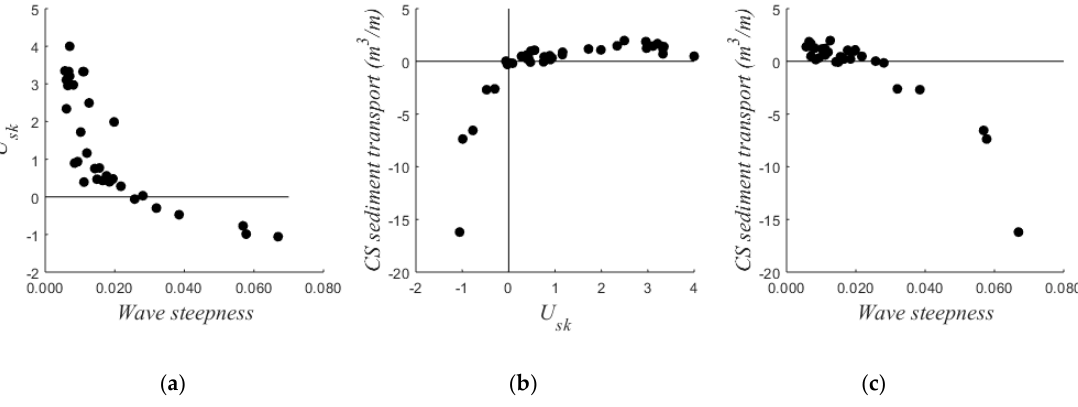
Figure 7. ( a ) Velocity skewness (U sk , 30 cm above the bed) over wave steepness; ( b ) cross-shore (CS) sediment transport over U sk ; ( c ) CS sediment transport over wave steepness. Each point represents one tidal cycle. Cross-shore sediment transport represents the transport per meter beach width in the lowest meter of the water column and is the average of the measurements of the 3 optical backscatter sensors.